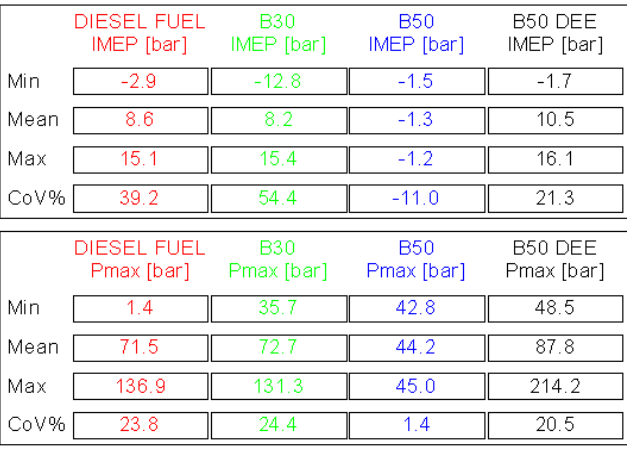
Figure 10. Cyclic dispersion over the first 200 engine cycles.